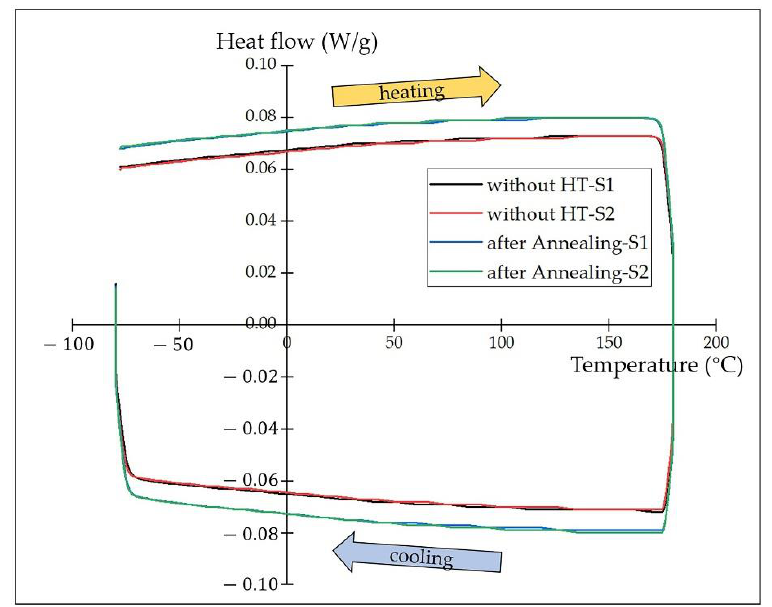
Figure 8. DSC curves of 55NiTi+5Ni coating before and after annealing under 850 °C.